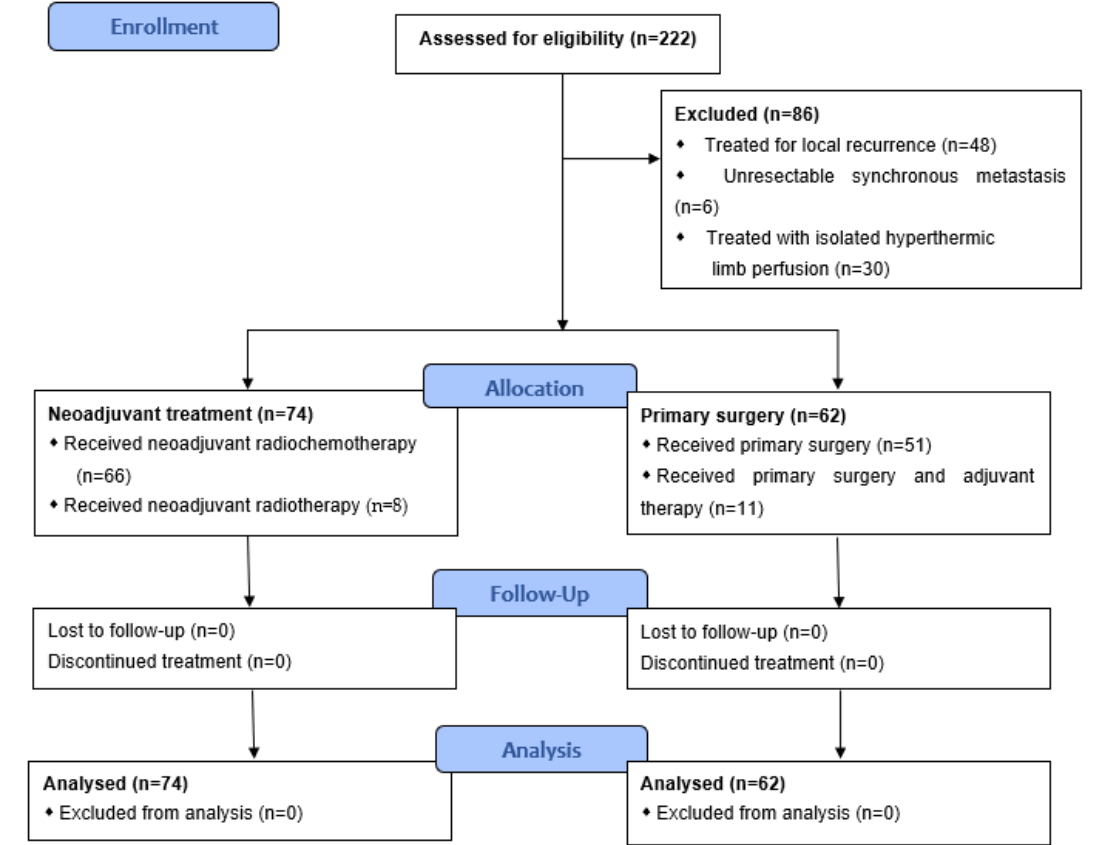
Figure 1. CONSORT flow diagram of the study.